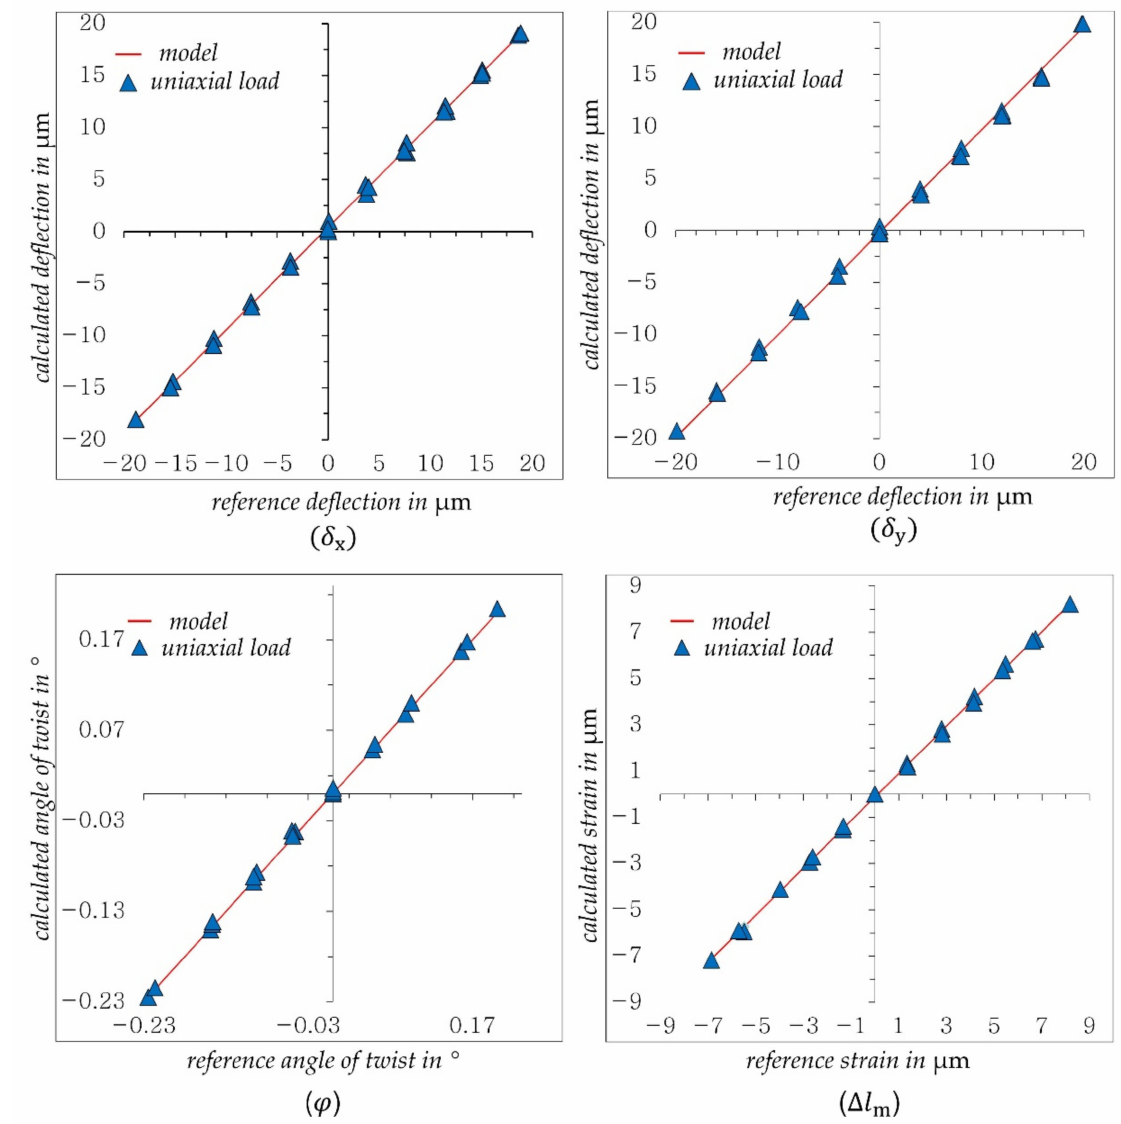
Figure 7. Measurement accuracy achieved for uniaxial in comparison with reference